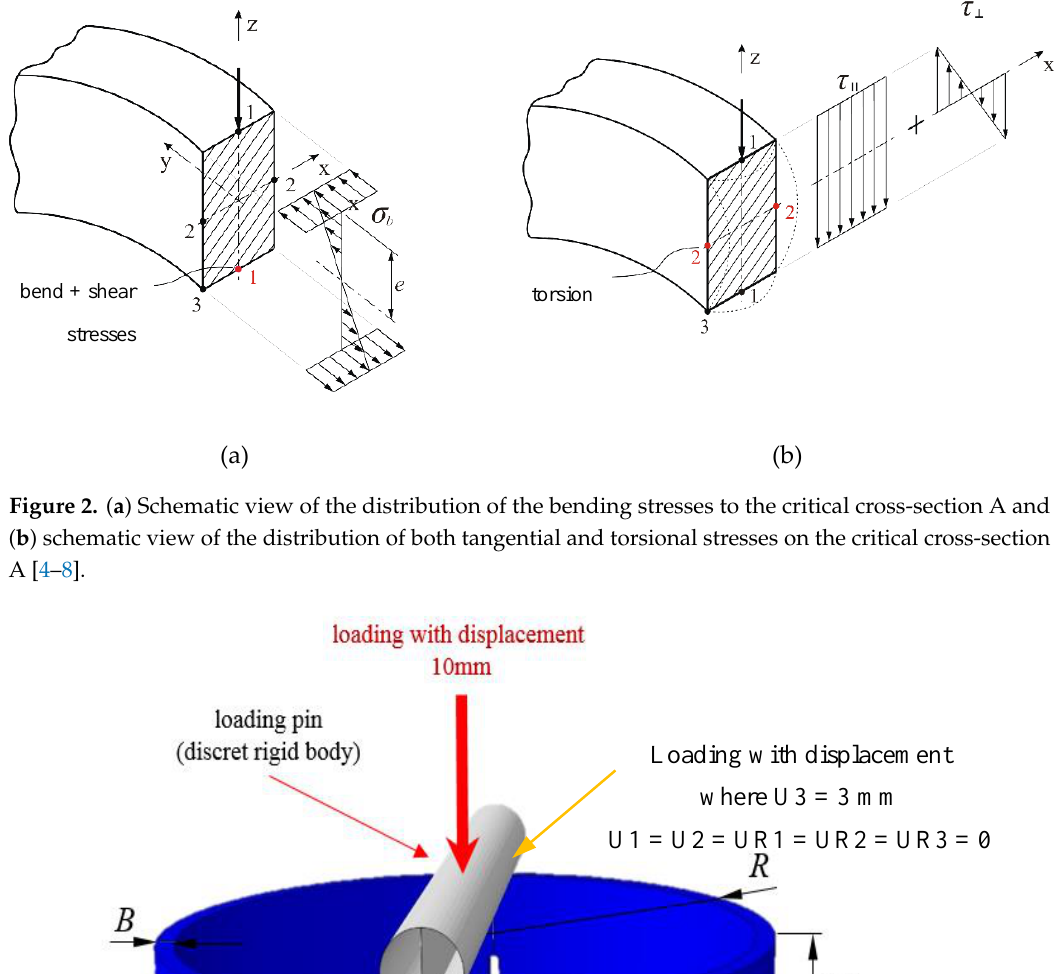
Figure 1. The scheme of the ring bending in the axial direction, with both sections A and B [4–8].